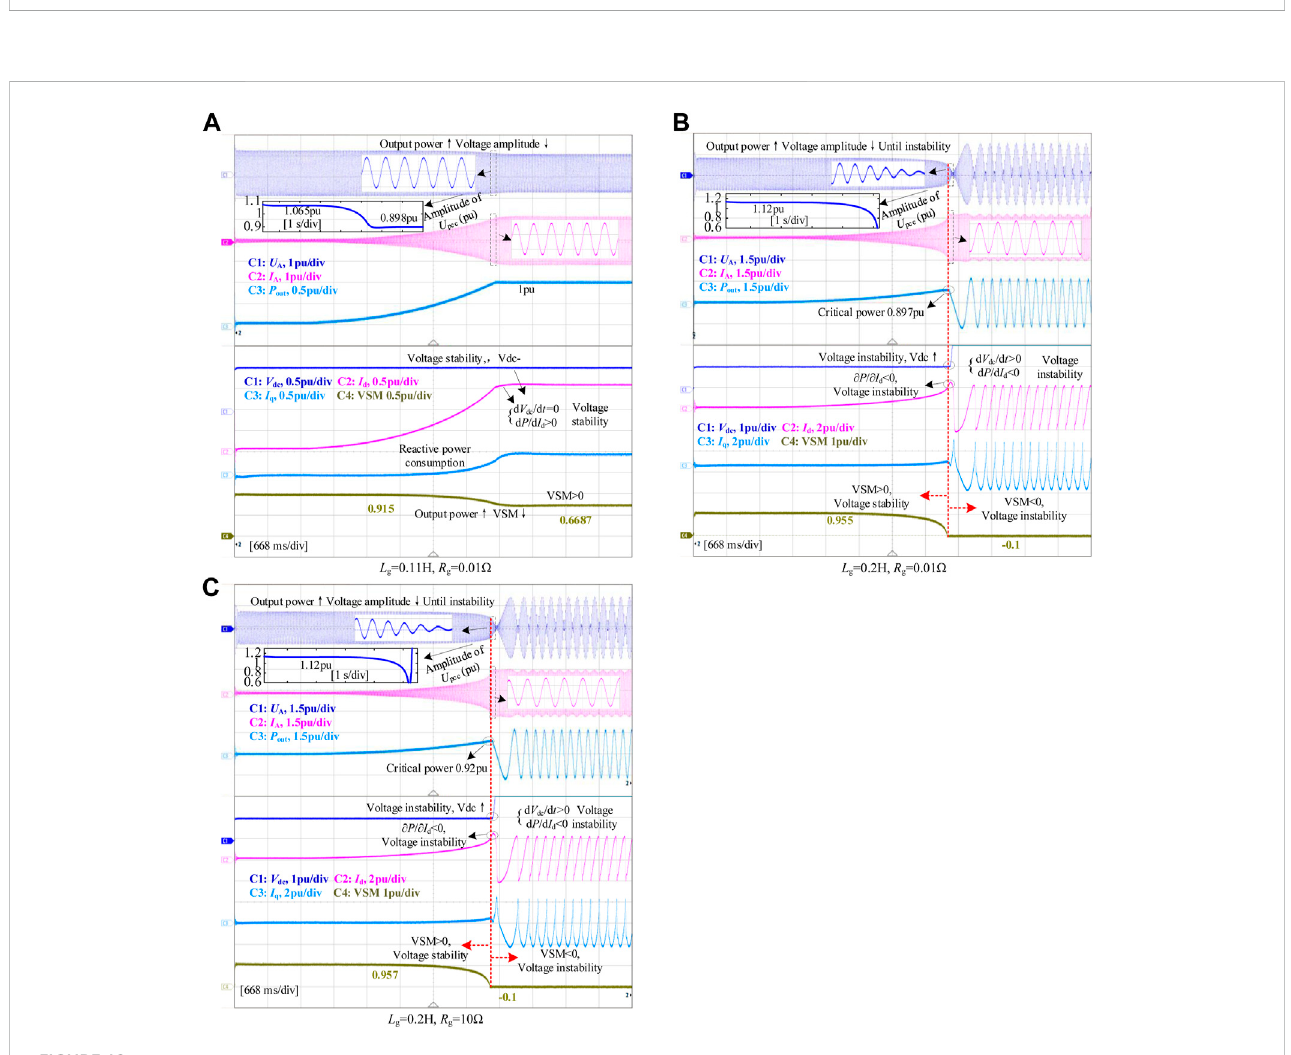
FIGURE 12 Comparison of VSM under different grid impedances, (A) L g = 0.11H, R g = 0.01 Ω , (B) L g = 0.2H, R g = 0.01 Ω , (C) L g = 0.2H, R g = 10 Ω